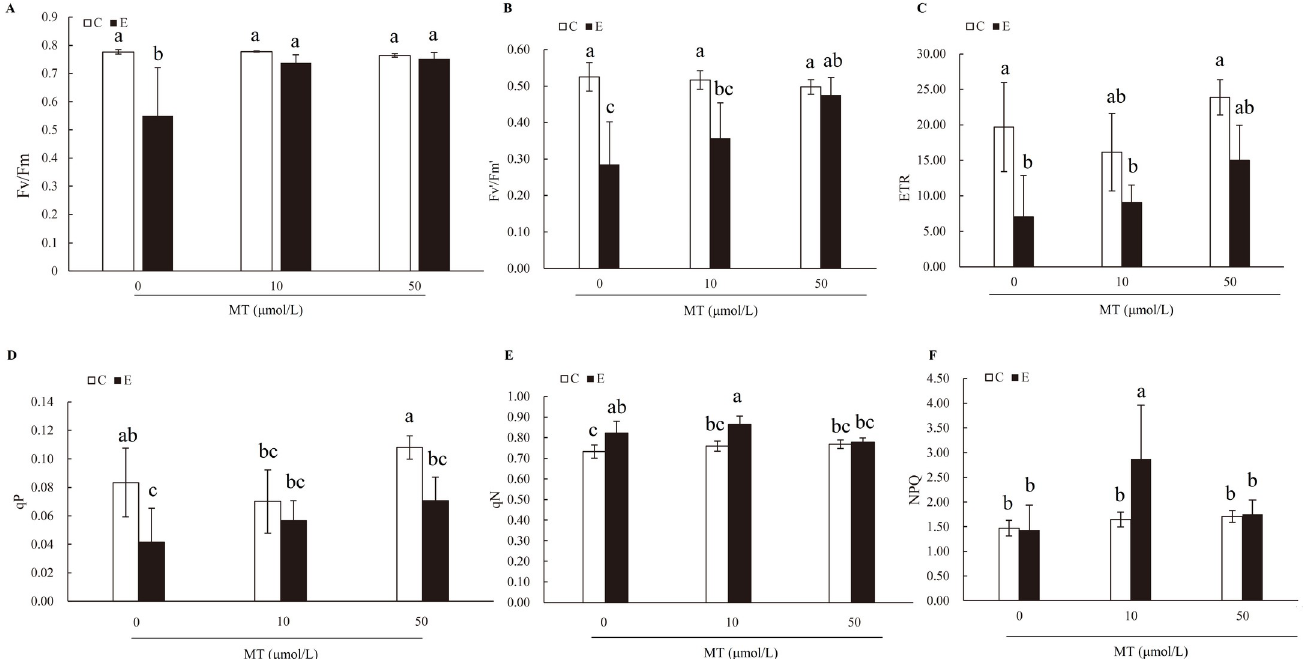
Fig 2. Melatonin alleviated the photosynthetic damage of tomato leaves under PEG6000 simulated drought treatment. Maximum photochemistry efficiency of photosystem (PS)II (Fv/Fm) (A), effective quantum yield of PSII photochemistry (Fv 0 /Fm 0 ) (B), electron transfer rate (ETR) (C), photochemical quenching (qP) (D), non-photochemical quenching coefficient (qN) (E), and non-photochemical quenching (NPQ) (F) of tomato leaves after combined application of different concentrations of melatonin (0, 10, 50 μ mol/L) under normal and PEG6000 simulated drought. The experiments were repeated three times for each and the statistical data are presented as the mean ± standard deviation. Differences were compared by Duncan’s test with a significance level of p < 0.05.